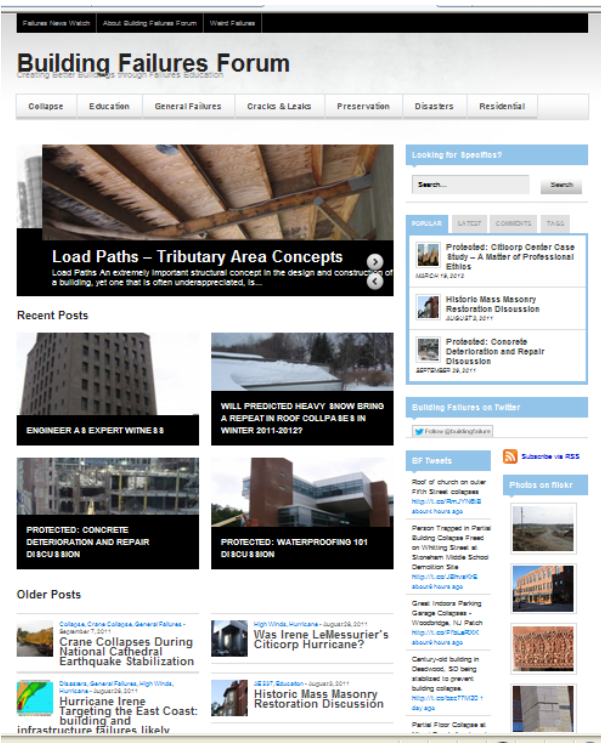
Figure 3. Screen Capture of Homepage of Building Failures